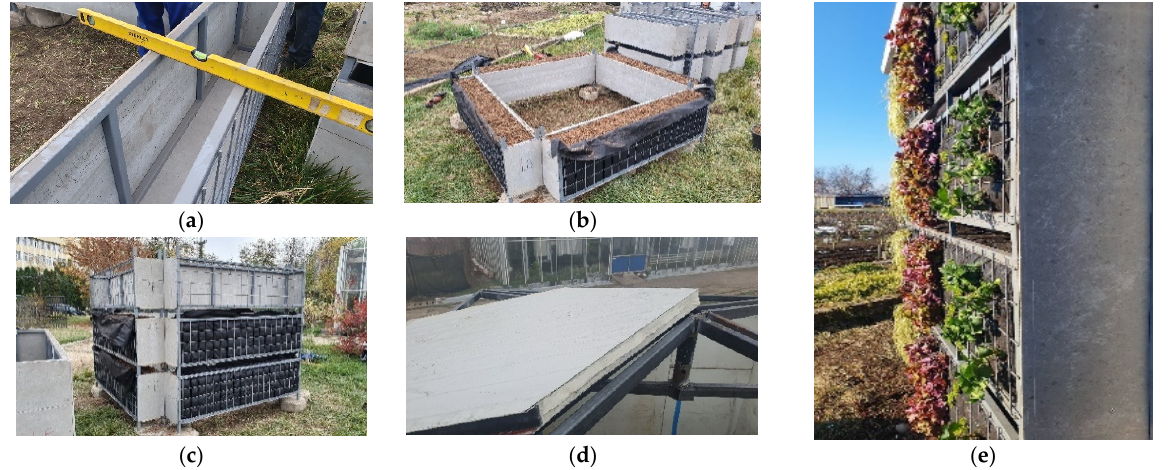
Figure 1. Realization of experimental structures: ( a ) flatness check 1; ( b ) fitting the first level of the experimental structure C1; ( c ) mounting the upper tiers; ( d ) insulation of the roof with heat-insulating panels; and ( e ) planted facade (south) of the experimental structure C2.